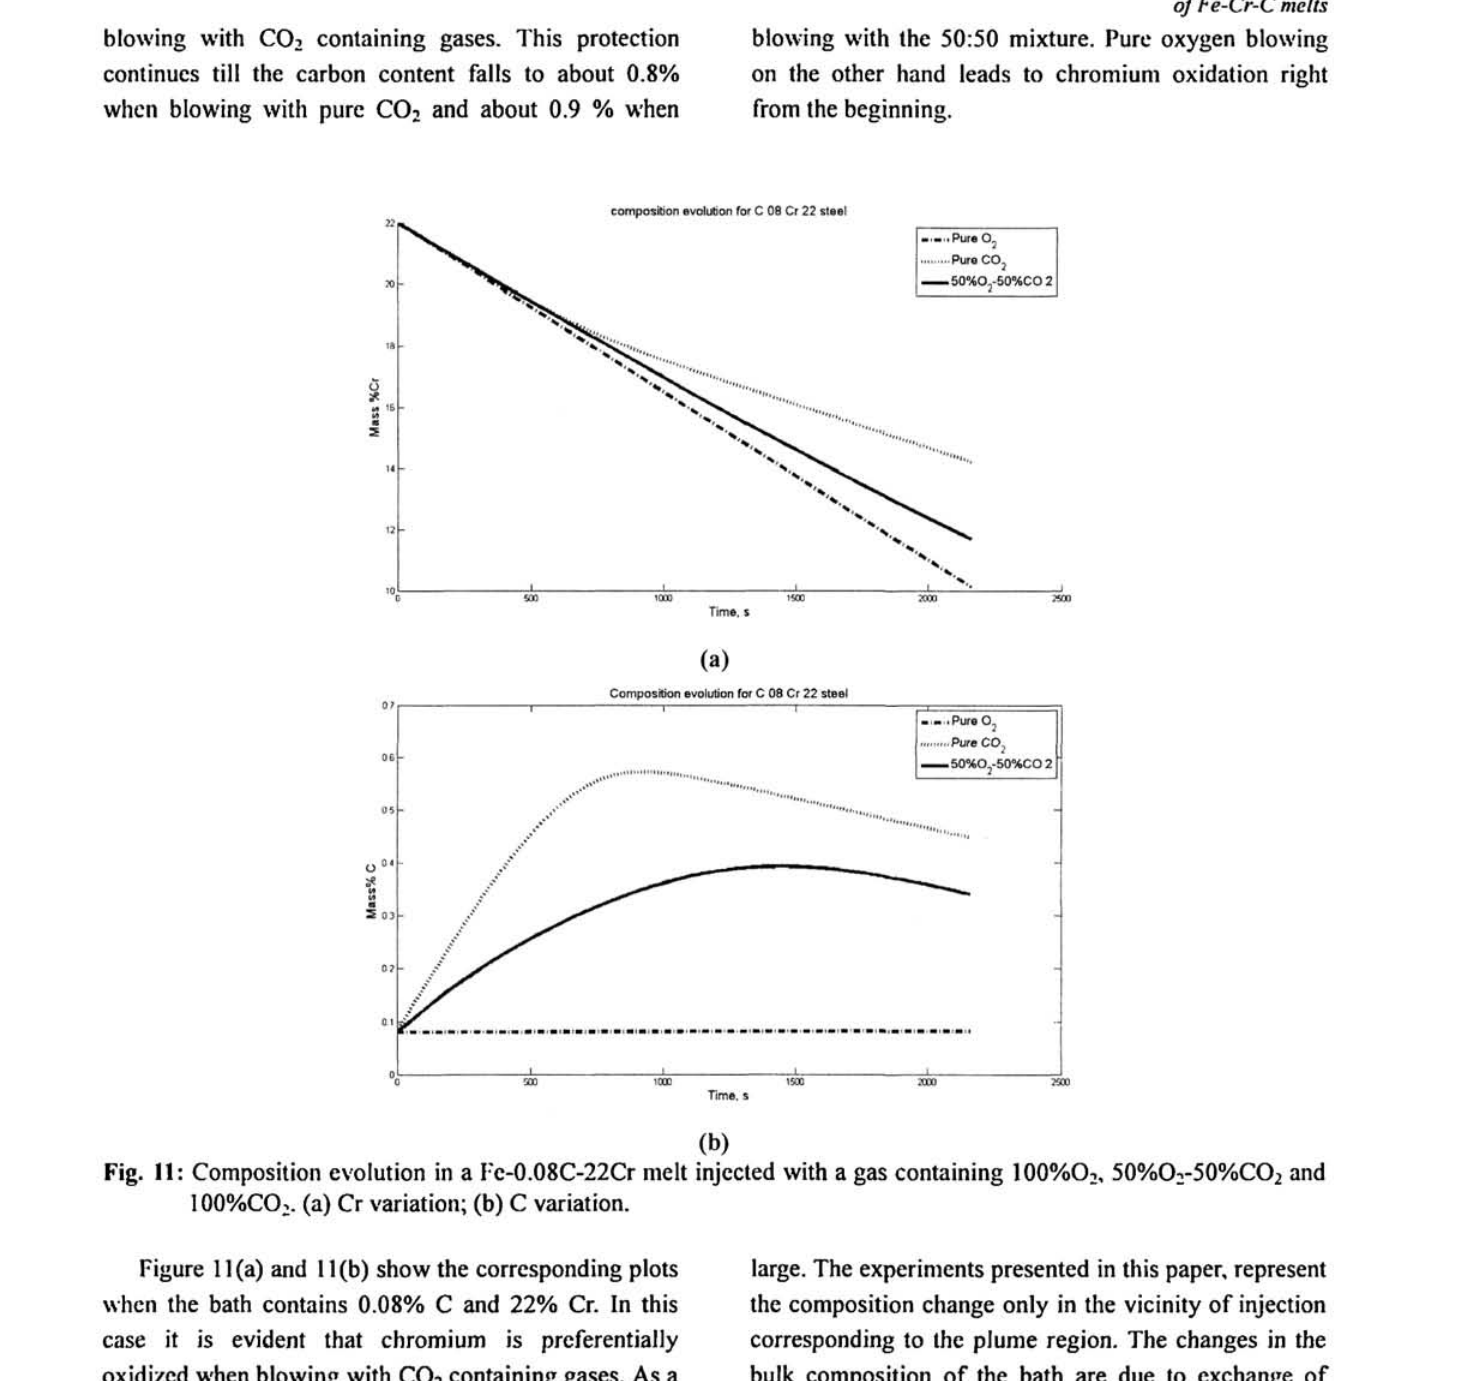
, 50%0 -50%CO and 2 2 2